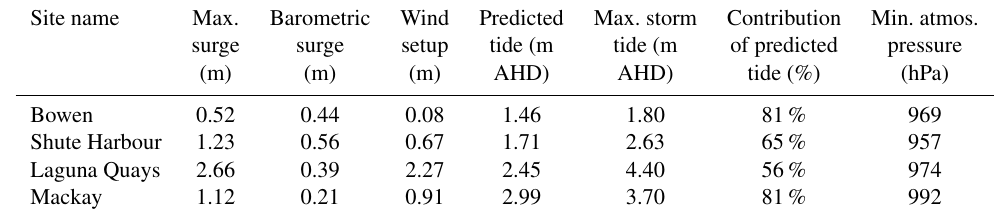
Table 2. Maximum surge, storm tide and minimum atmospheric pressure recorded at gauges (north to south) during Debbie . Calculations of barometric surge and wind setup components of the maximum surge are given. The time of maximum storm tide coincided with the astronomical high tide (approx. 2h before landfall), not the time of maximum surge (which occurred 1–2h after landfall for the southern sites). The predicted astronomical tide height at the time of maximum storm tide is shown below.